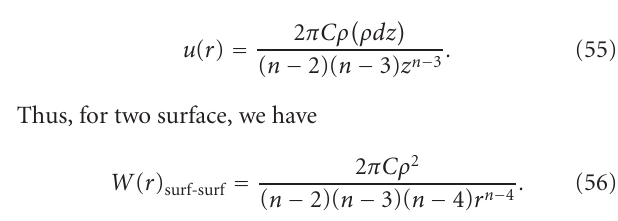
Figure 7: Shows micrograph after 2000 Monte Carlo cycles (3D NVT-MC simulation of linear polymer). Circular holes are created in the polymer film caused by rupturing mechanism (i.e., spinodal dewetting). The polymer film is sandwitched between two hard walls. k B T = 1 . 8 and sping constant of the film are taken as K = 200. Metropolis function has been used by performing a complete self avoiding random walk on the beads of the chains. FENE potential has been used for intrachain beads and Morse potentail for interaction between inter- and intrachain beads. The lower substrate has weak attractive potential to the beads. Peroidic boundary conditions are applied in X direction. Program has been developed by the author in